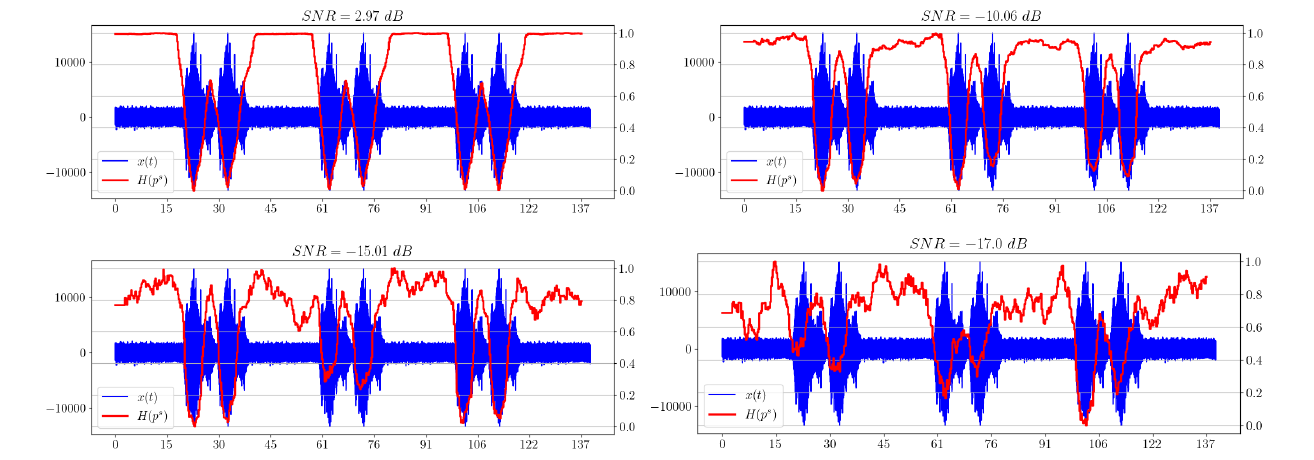
Figure 8. Spectral entropy plots for different SNRs.